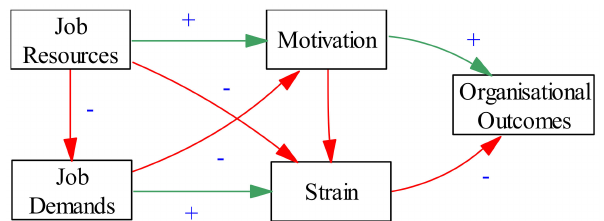
Figure 2. The Job Demand–Resources (JD–R) model (adapted from Bakker and Demerouti, 2007 [7]). Note: green arrows indicate positive causal relations, and red arrows indicate negative causal relations.